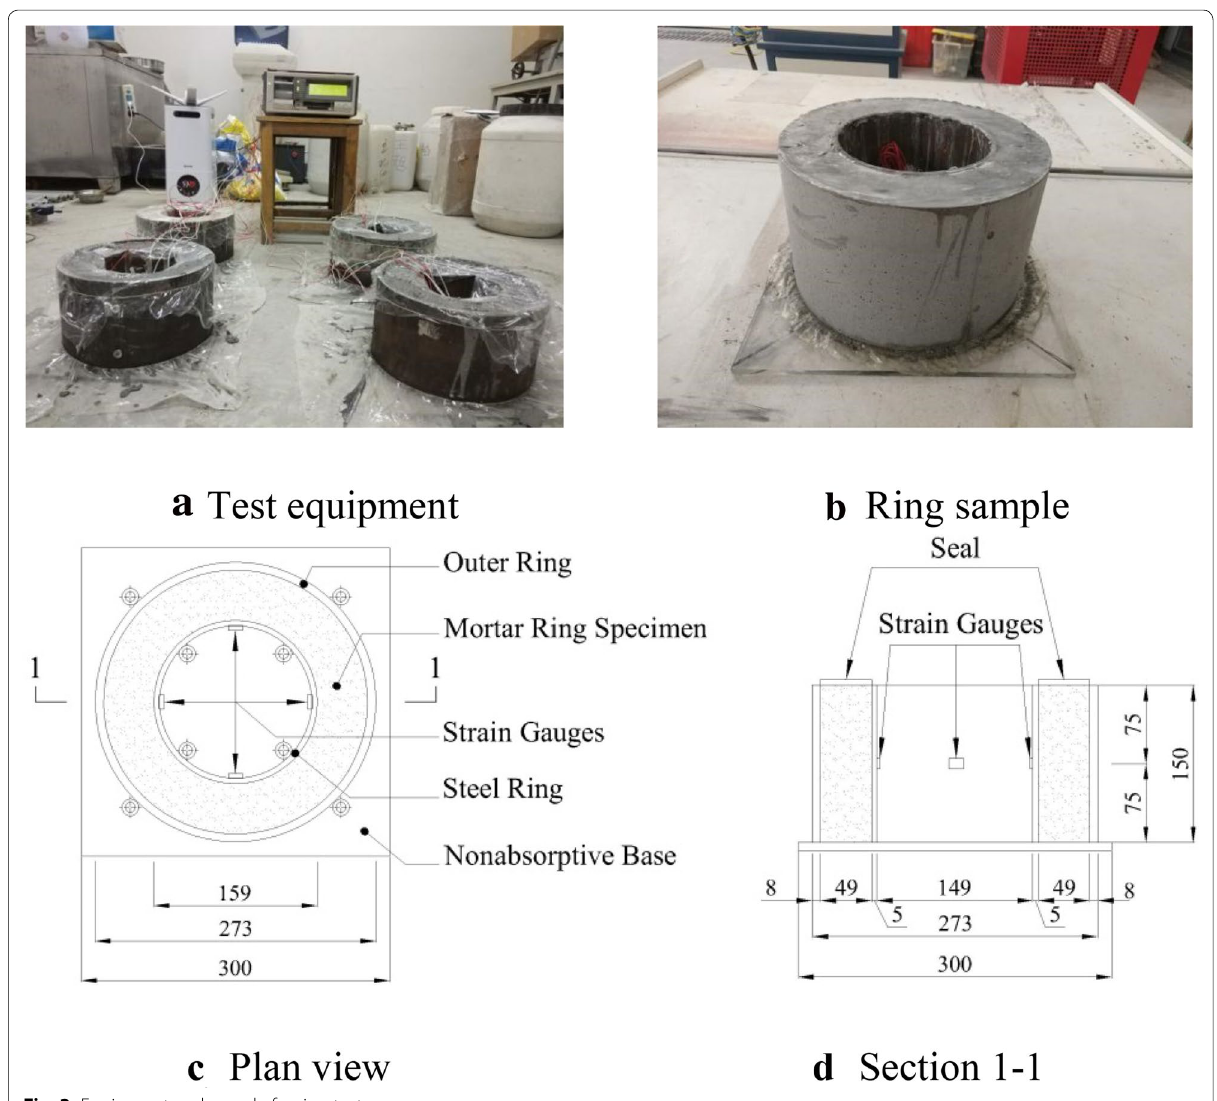
Fig. 3 Equipment and sample for ring test.